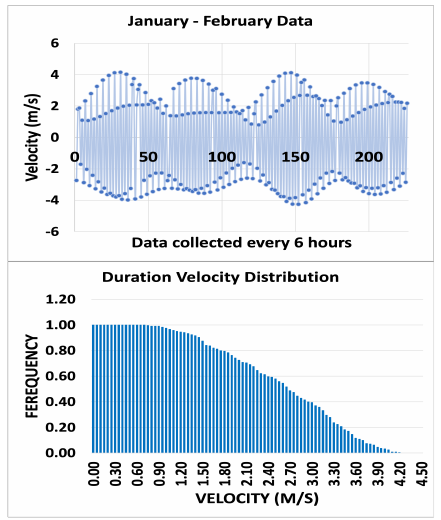
Fig. 22. Current time series at Ganzirri, Messina strait (top), and probability of exceedence (PoE) of current speed (bottom).